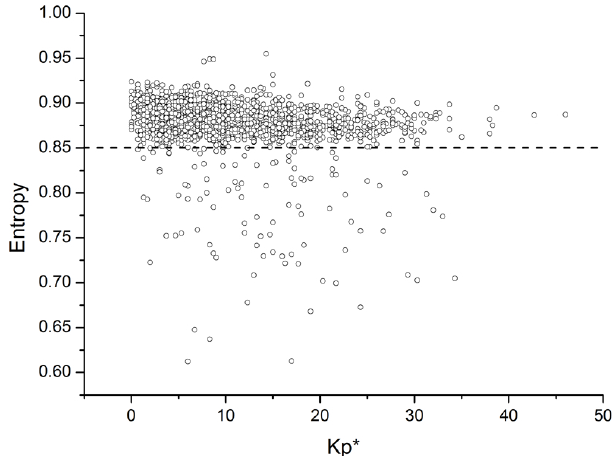
Fig. 4. Entropy vs. K p *. Below the dashed line there are the lowest entropy values (entropy lower than 0.85) mostly reached during the first part of 2008. There is no clear correlation between the two quantities, especially during the latter